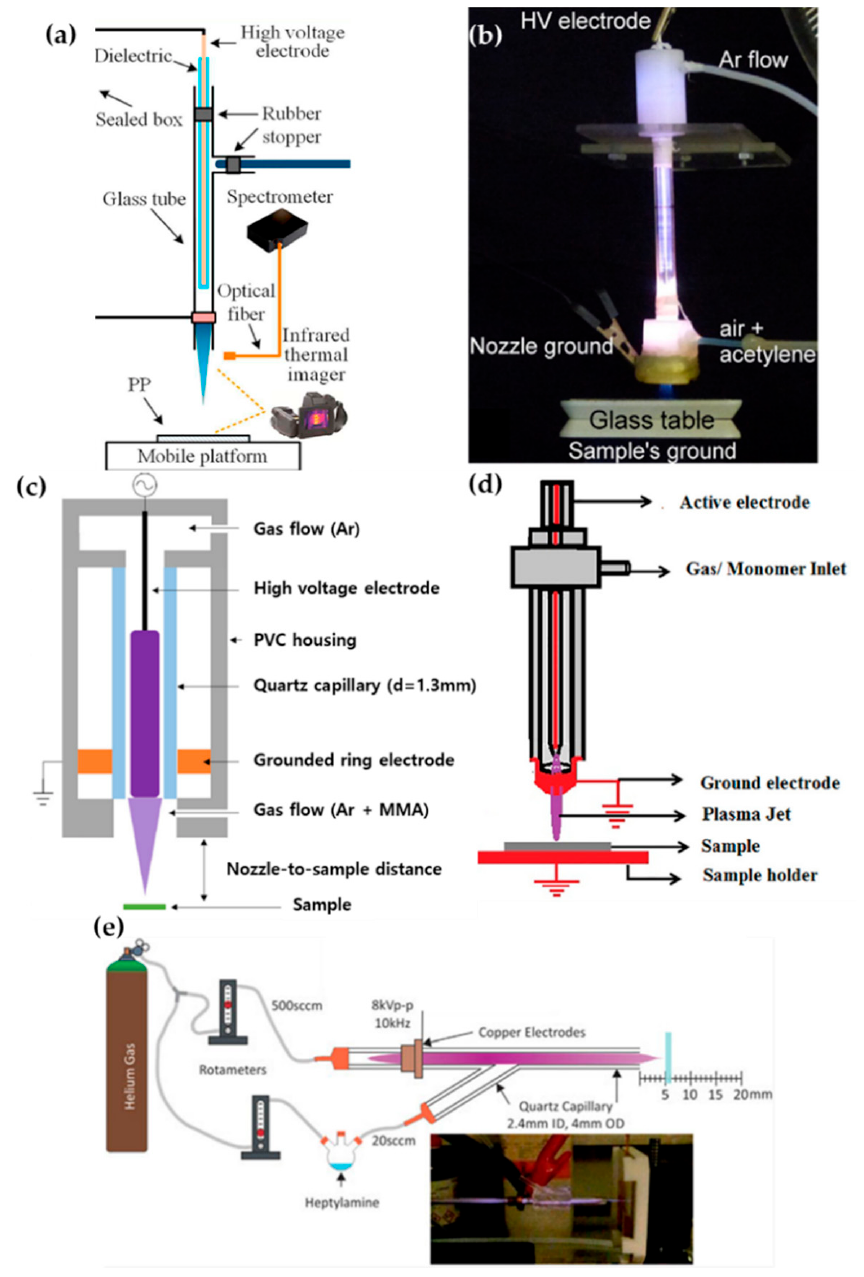
Figure 2. Structures of pin–ring-electrode-type APPJs from ( a ) Zhang et al. [51], ( b ) Ricci Castro et al. [52], ( c ) Van Vrekhem et al. [53], and ( d ) Pandiyaraj et al. [54], and ( e ) schematic of experiment using a y-shaped APPJ with a ring powered electrode, by Doherty et al. [55].